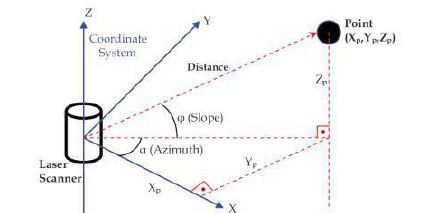
Figure 1. Laser scanning measuring technology (CDOT, 2011) Terrestrial laser scanners scan the surface of object by obtaining X, Y, Z coordinates within seconds, possibly with color information, i.e., RGB (Red, Green, and Blue) depending on the function of the scanner and the distance between the scanner and the object. The point cloud data acquired by the scanning process may be in an XYZIRGB (X, Y, Z coordinate, return Intensity, and Red, Green, Blue color values) format if color information is available. The point cloud data structure is shown in Table 1. Table 1 Point cloud data structure Coordinates